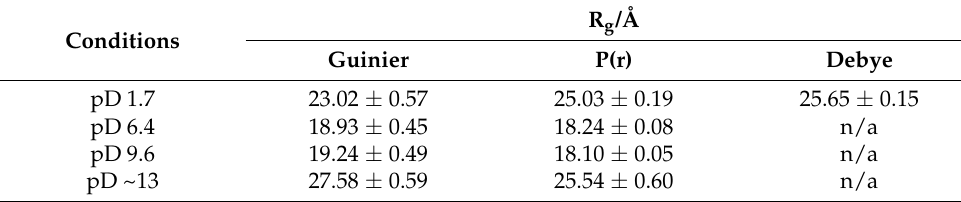
Table 2. Simulated R g values calculated from the crystal structures at pH 6.0 (PDB 4WGZ) and 10.4 (PDB